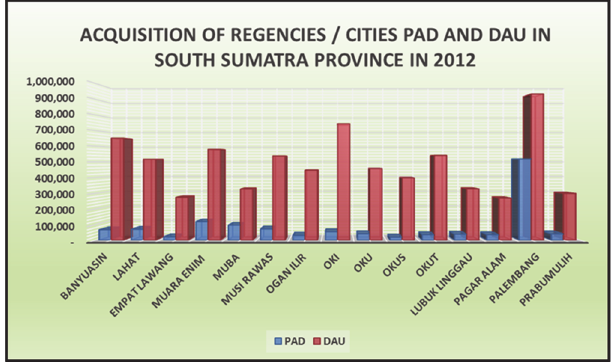
Fig. 3. Acquisition of Regencies / Cities PAD and DAU in South Sumatra Province in 2012